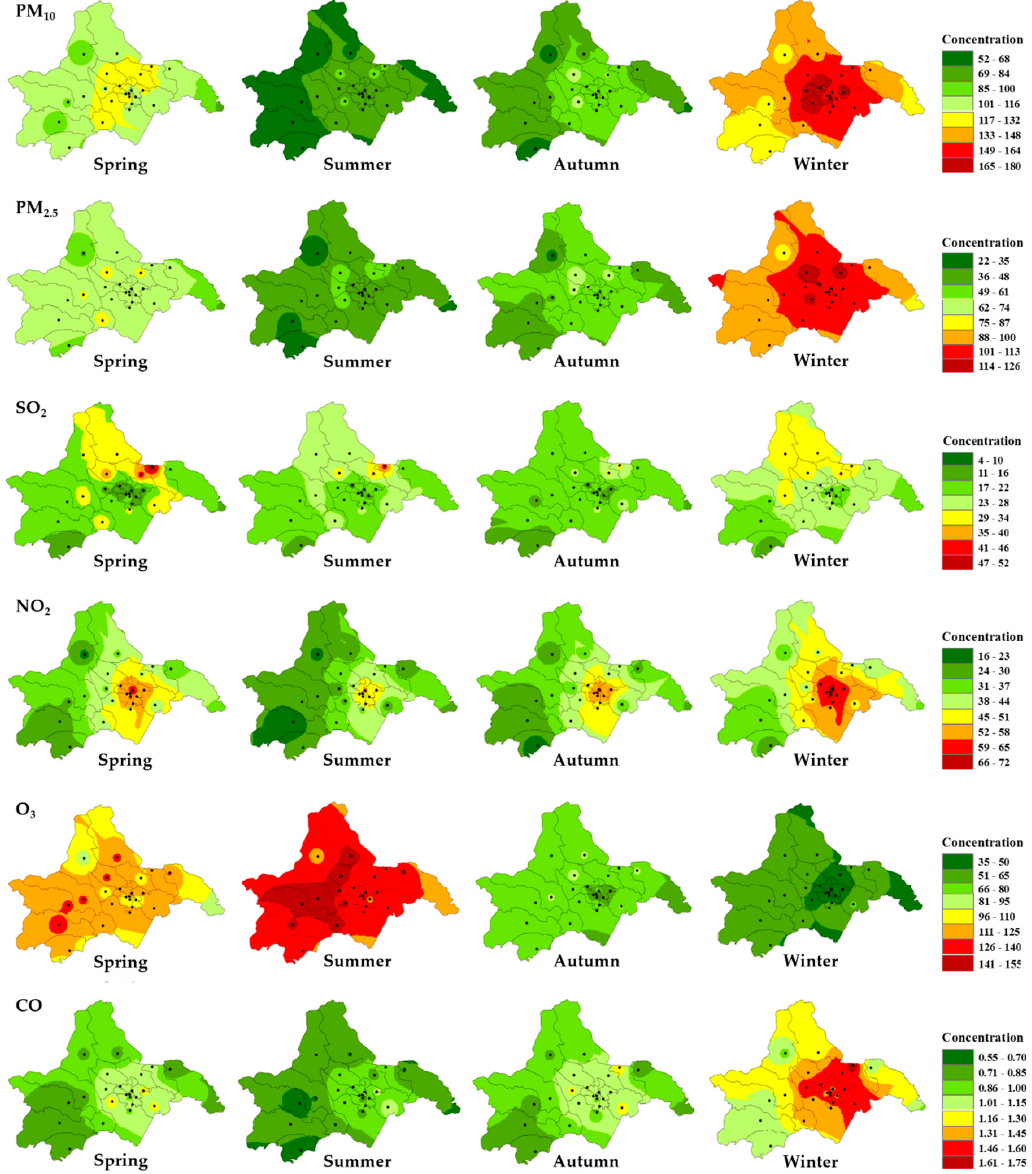
Figure 4. Seasonal variation in air pollutants in Chengdu during 2014–2016. The units for PM 10 , PM 2.5 , SO 2 , NO 2 and O 3 are µg m –3 , whereas that for CO is mg m –3 . However, the concentration of O 3 displayed the opposite seasonal variation, with the highest value in summer (136 ± 9 µg/m 3 ) and the lowest value (53 ± 9 µg/m 3 ) in winter. Weak sunlight in winter could inhibit the formation of O 3 as the formation rate of O 3 depends on the intensity of solar